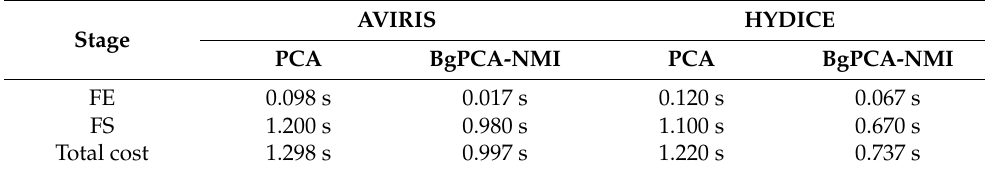
Table 7. Computational time in seconds (s) of the proposed and studied methods.